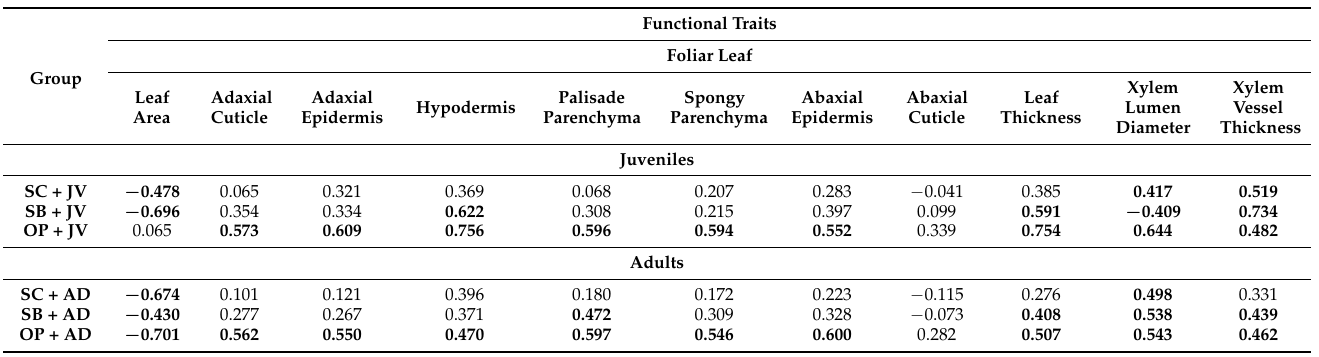
Functional Traits Foliar Leaf